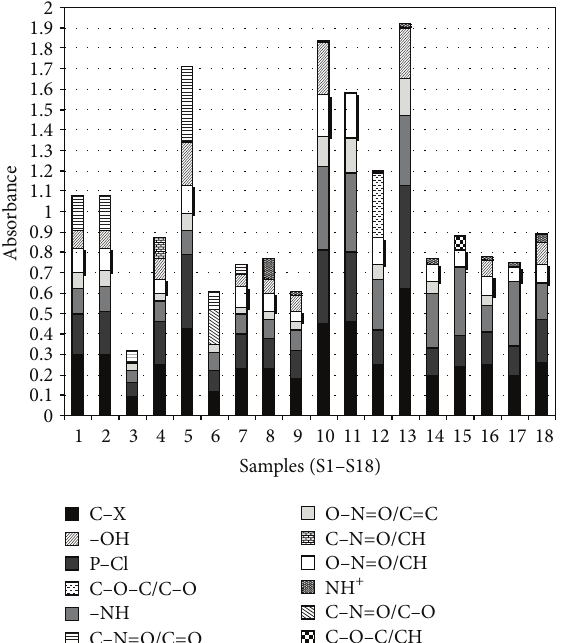
Figure 2: The number, type, and absorbance value of the main functional groups in